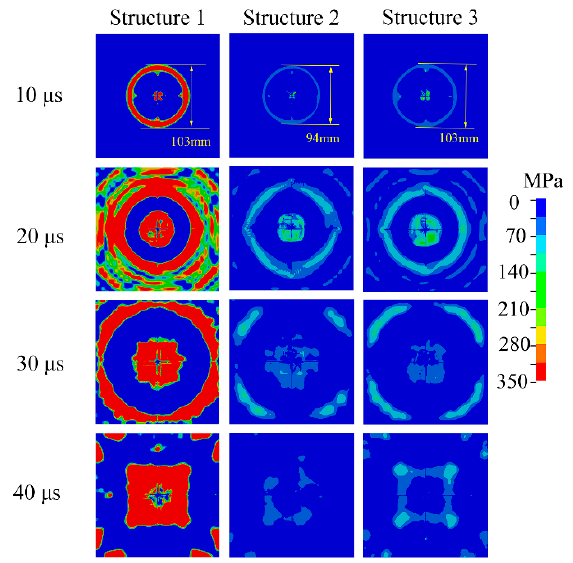
Figure 8. The evolution of the tensile stress of the ceramic’ rear surface with time.